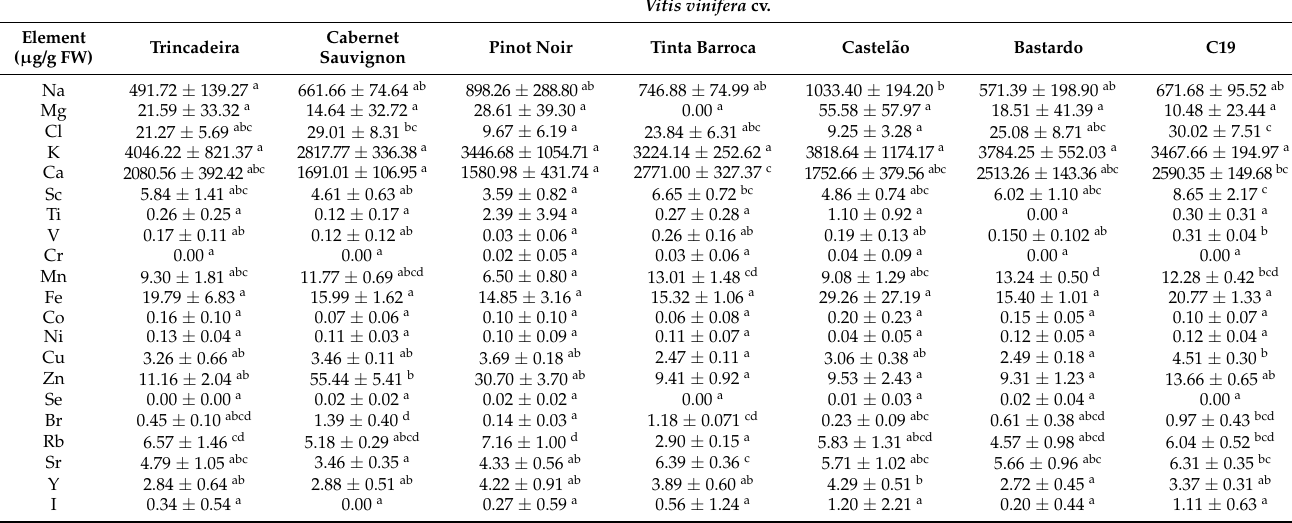
Table 3. Average concentration and standard deviation of each element analysed through total reflection X-ray fluorescence (TXRF) in grapevine leaves. N = 5, for a given row, different letters indicate significant differences at p < 0.05; same letters indicate no significant differences ( p > 0.05) (Kruskal–Wallis test).